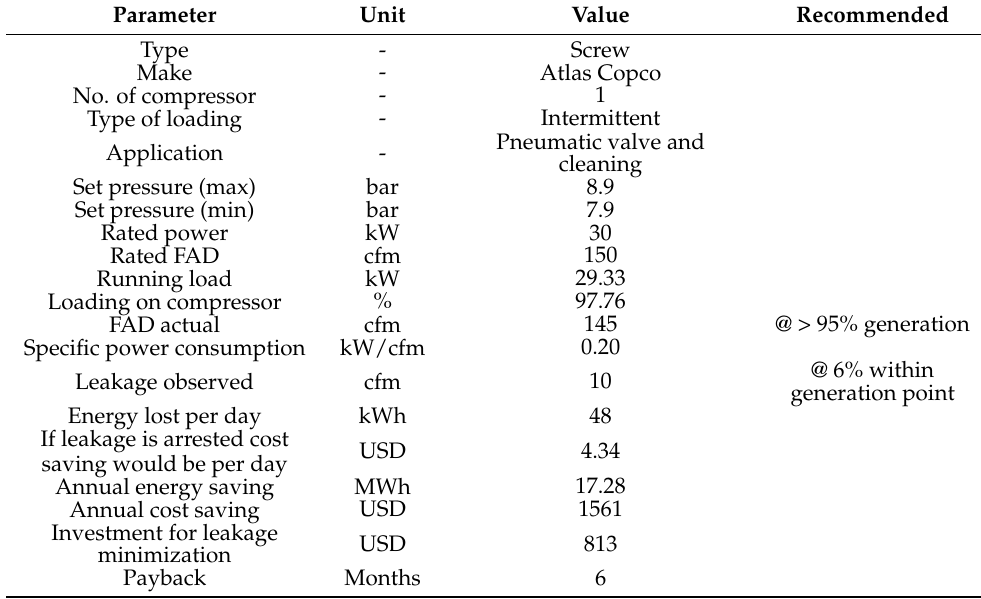
Table 12. Air compressor performance analysis.